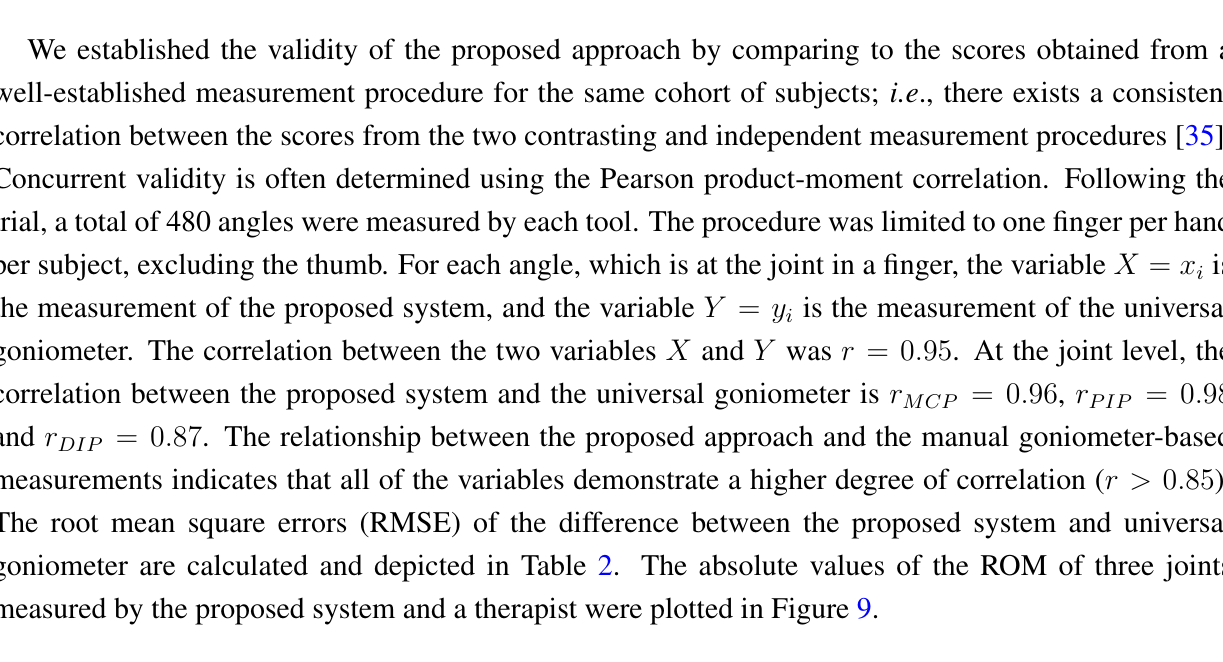
Comparison between the proposed system and universal goniometer. MCP, metacarpophalangeal joint; DIP, distal interphalangeal joint; PIP, proximal interphalangeal joint.